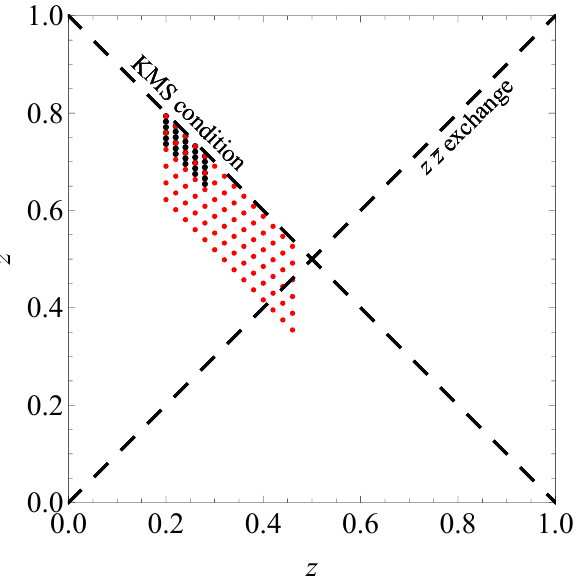
Figure 13. Example of the smallest (black) and largest (red) regions in ( z , z ) where we minimize the square of the di(cid:11)erence of the two-point function and it’s periodic image, as in (4.49). T 0 ; both belong to the [ (cid:27)(cid:27) ] family, whereas the [ (cid:15)(cid:15) ] family has no such operators 1 0